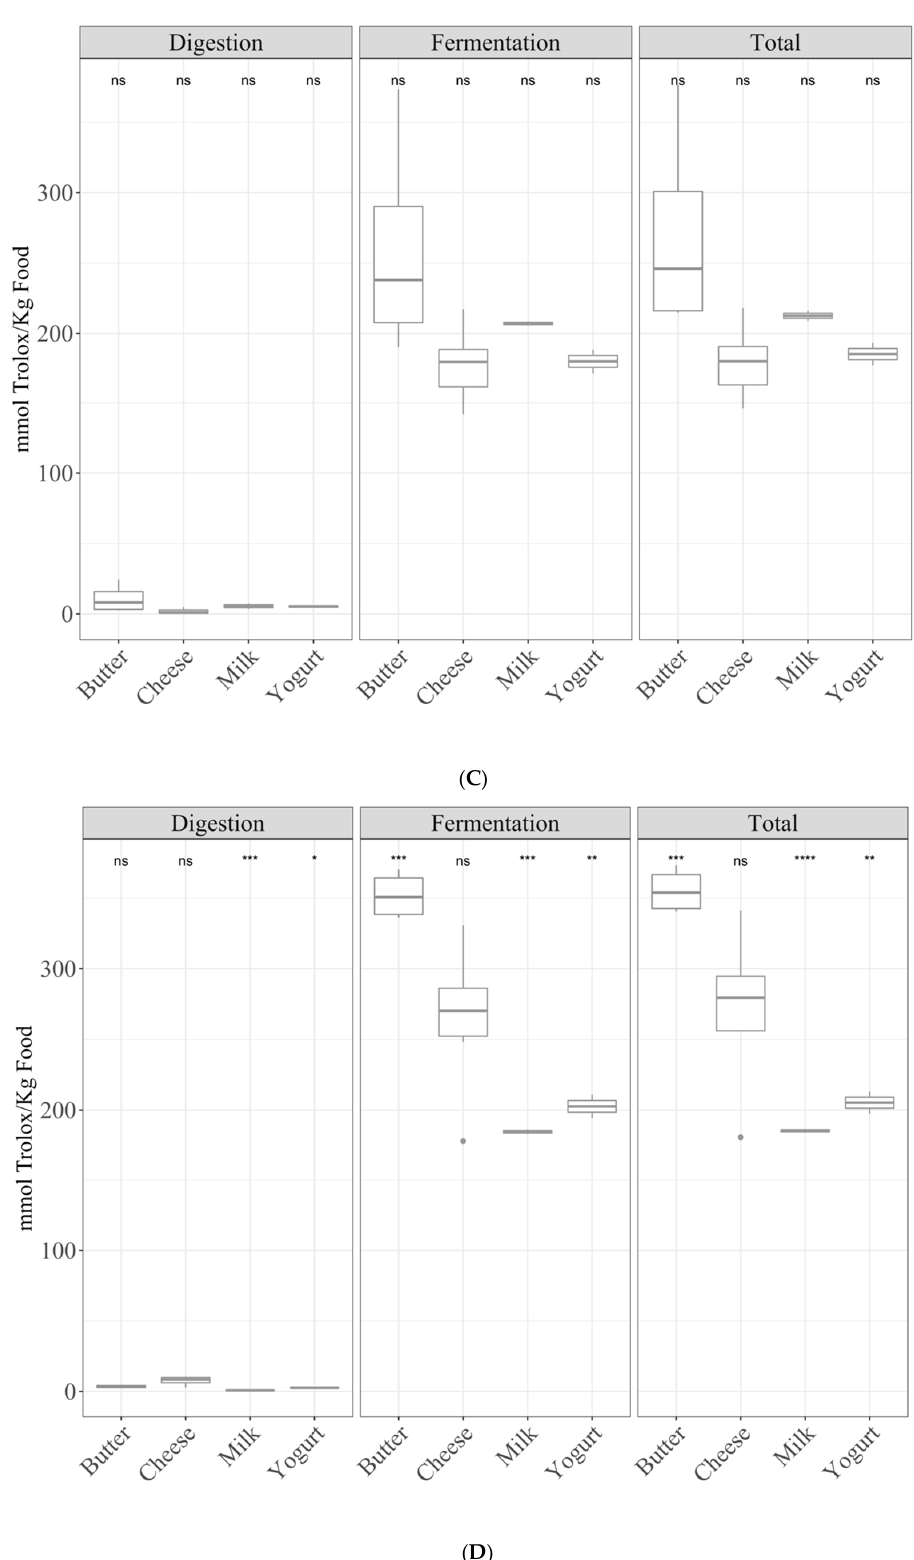
Figure 4. Antioxidant capacity of digested-fermented daily products (butter, cheese, milk and yogurt) depending on the cooking technique (( A ) TEAC DPPH , ( B ) TEAC FRAP ) and depending on the sample (( C ) TEAC DPPH , ( D ) TEAC FRAP ). Statistical analysis was performed through ANOVA using raw vegetables to figures A and B or mean of all food groups to figures C and D as the reference group. Statistic labels: *: p < 0.05, **: p < 0.01, ***: p < 0.001, ****: p < 0.0001, ns: not